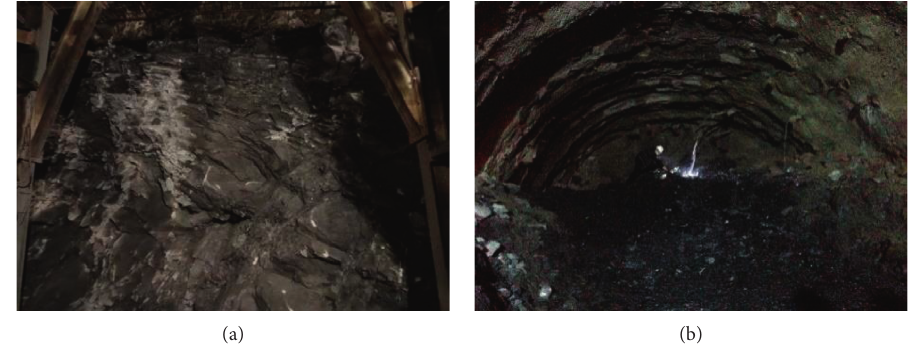
Figure 1: Tunnel face of HD3K0+148 section.